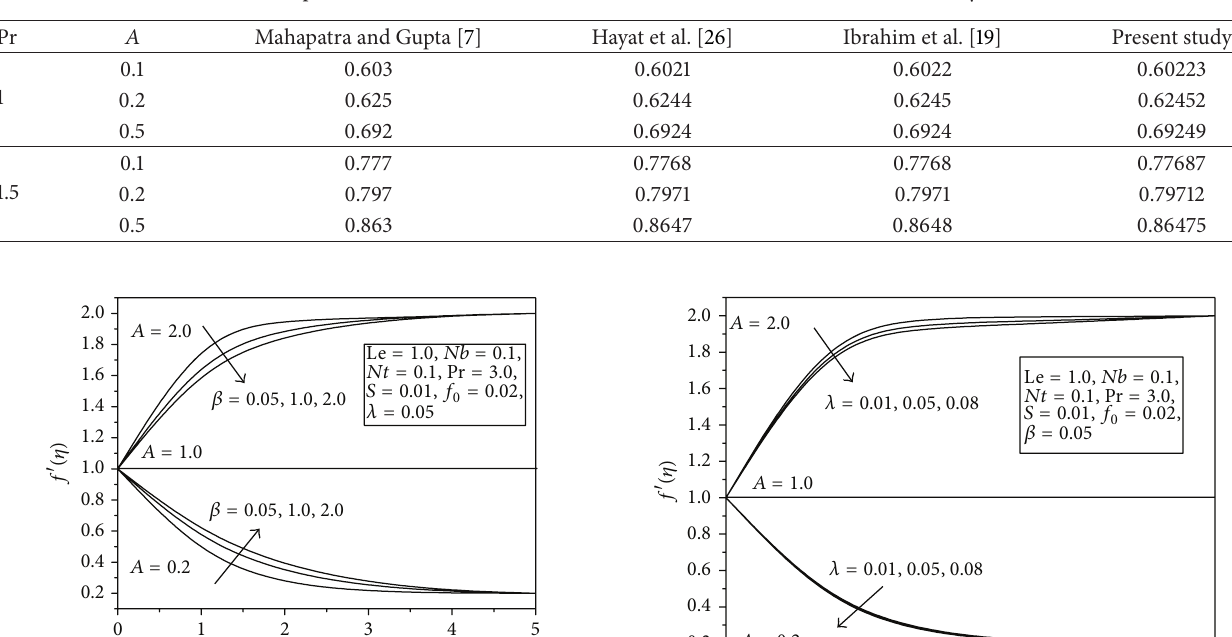
Table 2: Comparison of the values of Nusselt number −𝜃 󸀠 (0) for various values of velocity ratio 𝐴 .